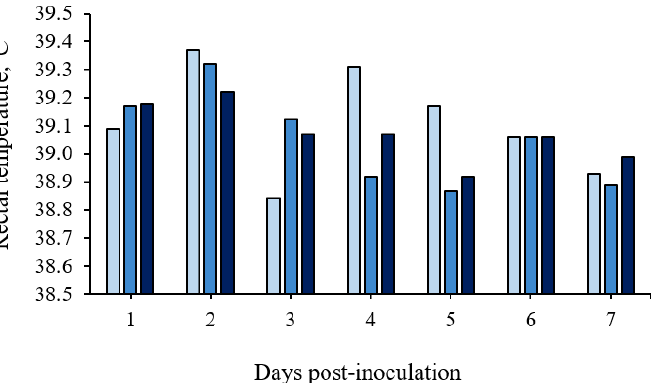
Figure 2. Rectal temperature means (°C) of growing pigs orally challenged or not with Salmonella Typhimurium. ( ■ ) Pigs without Salmonella Typhimurium (Basal); ( ■ ) Pigs orally challenged with 1 × 10 8 CFU of Salmonella Typhimurium; ( ■ ) Pigs orally challenged with 1.5 × 10 8 CFU of Salmonella Typhimurium. No differences between treatments were observed by the Tukey’s test ( p > 0.05). In Basal pigs, normal fecal consistency (score 0) was observed in 70% (7 out of 10 pigs) of the animals from 1 to 4 dpi and in 80% of the animals from 5 to 7 dpi. Transitory diarrhea